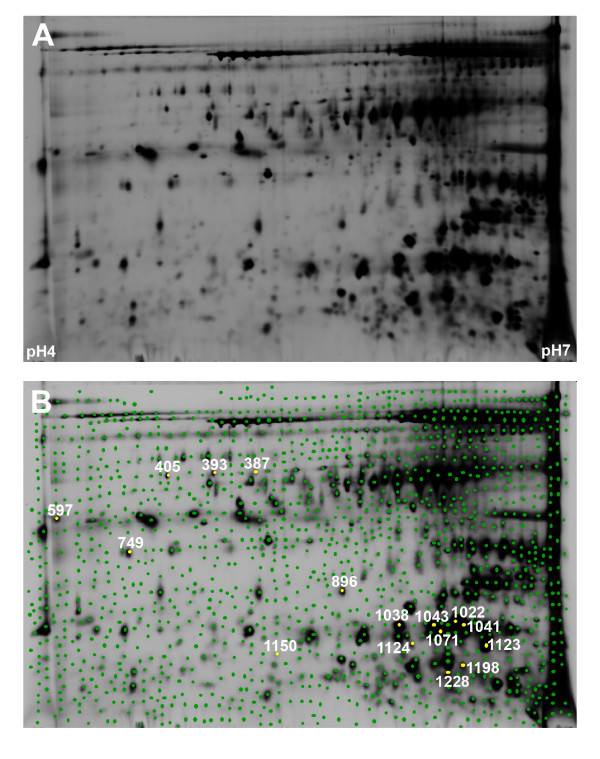
Representative Cy2-labelled internal standard proteome gel image illustrating proteins resolved in the pH4-7 range. The gel image as loaded into the DIA module prior to spot detection (A). In panel B the 1329 spot features, including spots at the edges of the gel that were outside the pH range of the 1st dimension separation, are each denoted by a green dot. The position of the 16 spot features used in the class prediction classifier have been marked with yellow and the associated master gel spot feature number assigned to the same spot features on all gels by the DeCyder BVA module are shown.